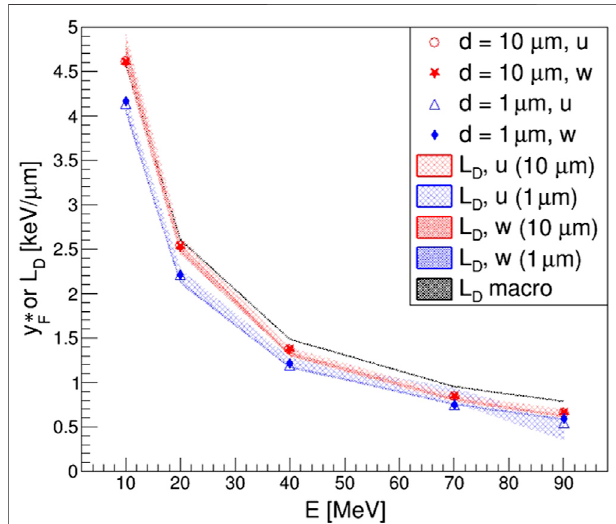
FIGURE 12 | Effective frequency-averaged lineal energy (cid:1) y * F as a function of the incident proton kinetic energy. Values obtained for uniform (open markers) and weighted (full markers) random sampling methods are compared for sites of 1 (blue triangles and diamonds) and 10 μ m (red circlesandstars)diameter.Valuesof (cid:1) y * F aresuperimposedtotherespective (cid:1) L D ones derived considering (cid:1) y * D instead of (cid:1) y D in Eq. 12 , represented as shaded areaswhosethicknessisgivenbytheerrorassociatedto (cid:1) L D foreachdiameter site. Finally, the macroscopic unrestricted (cid:1) L D computed with Eq. 13 is also reported as a reference. traversals of proton tracks through the site, especially for the (cid:1) l * values for the computation of highest energies. By using the F (cid:1) l * and , frequency- and dose-averaged effective lineal energies, (cid:1) y * D F